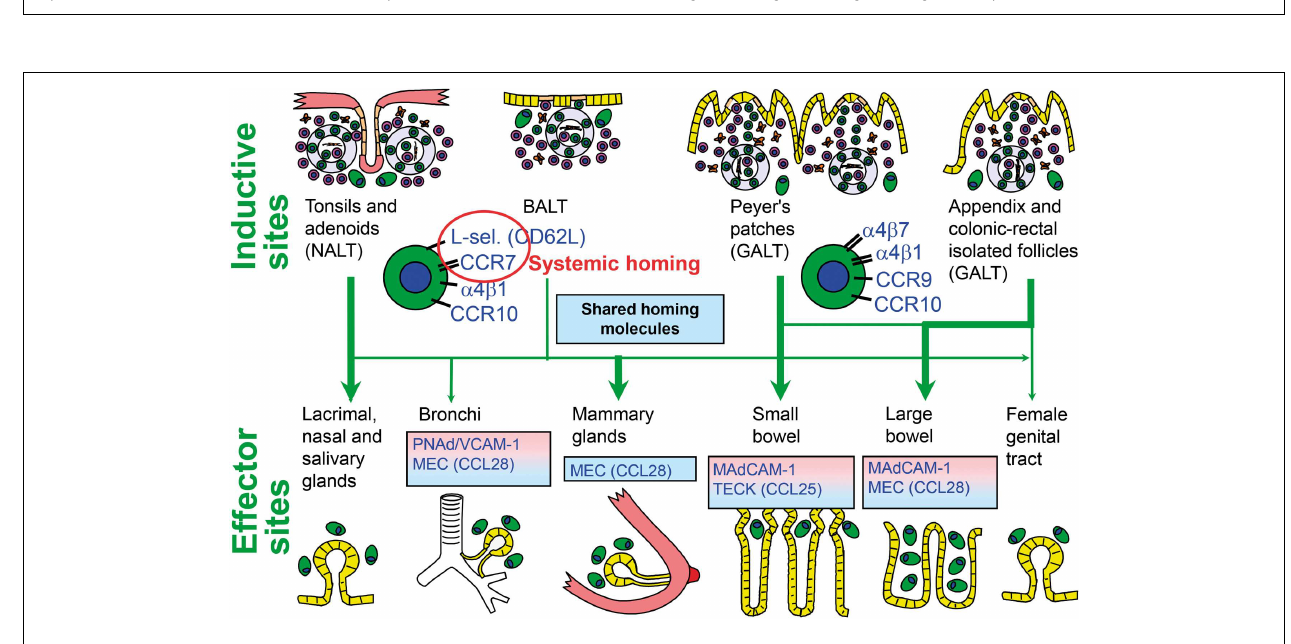
FIGURE 4 | Synopses of the structural basis for the excellent anti-microbial binding properties of secretory IgA (SIgA) . Domain interactions in the formation of SIgA based on data reviewed in Norderhaug et al. (29). Non-covalent interactions are shown between the J chain (J) and the extracellular domain 1 (D1) of bound secretory component (SC), and covalent disulfide bonding is indicated between cysteine 467 or 502 in D5 of bound SC and cysteine 311 in the C α 2